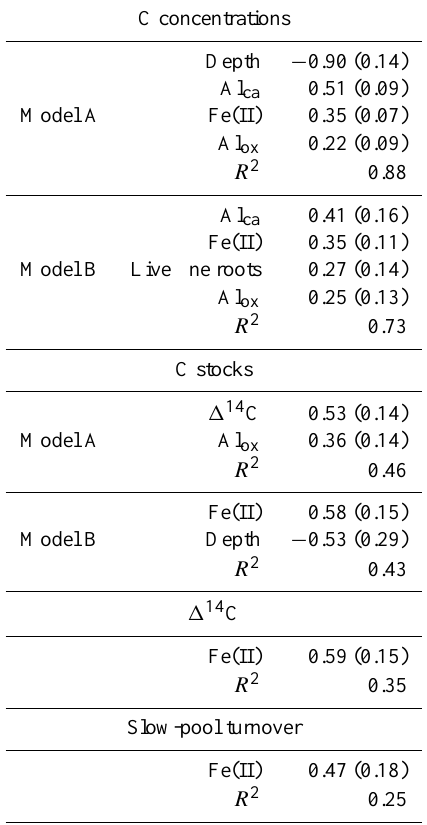
Table 4. Linear models of C concentrations, stocks, and slow-pool turnover. Normalized model coefficients (SE) are analogous to Pear- son’s r . See Table 2 for variable descriptions. Models A and B rep- resent different models with similar AIC.